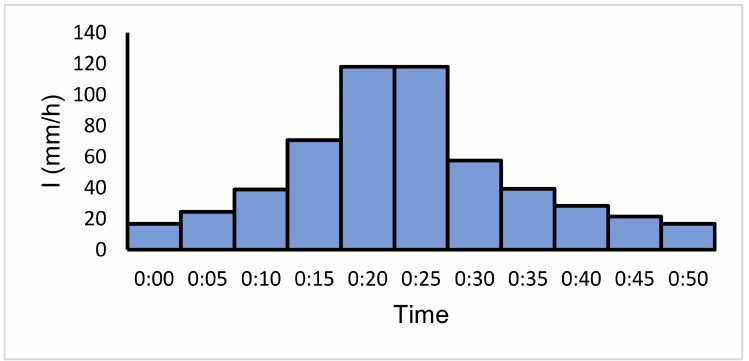
Figure 7. Design storm for the E-Chico network.